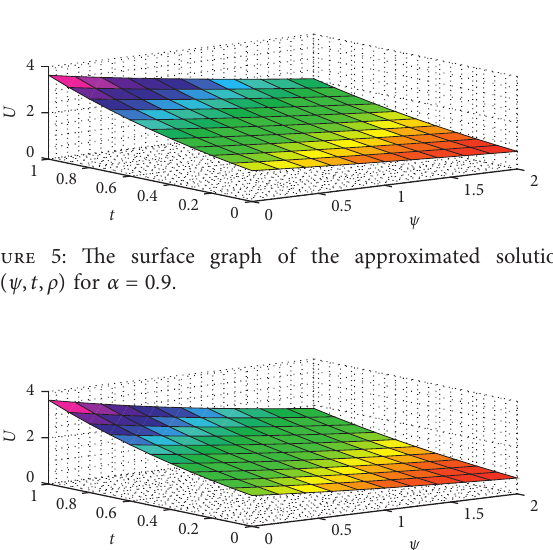
Figure 4: The surface graph of the approximated solution ( ψ ,t, ρ ) for α � 0 . 8. U 3